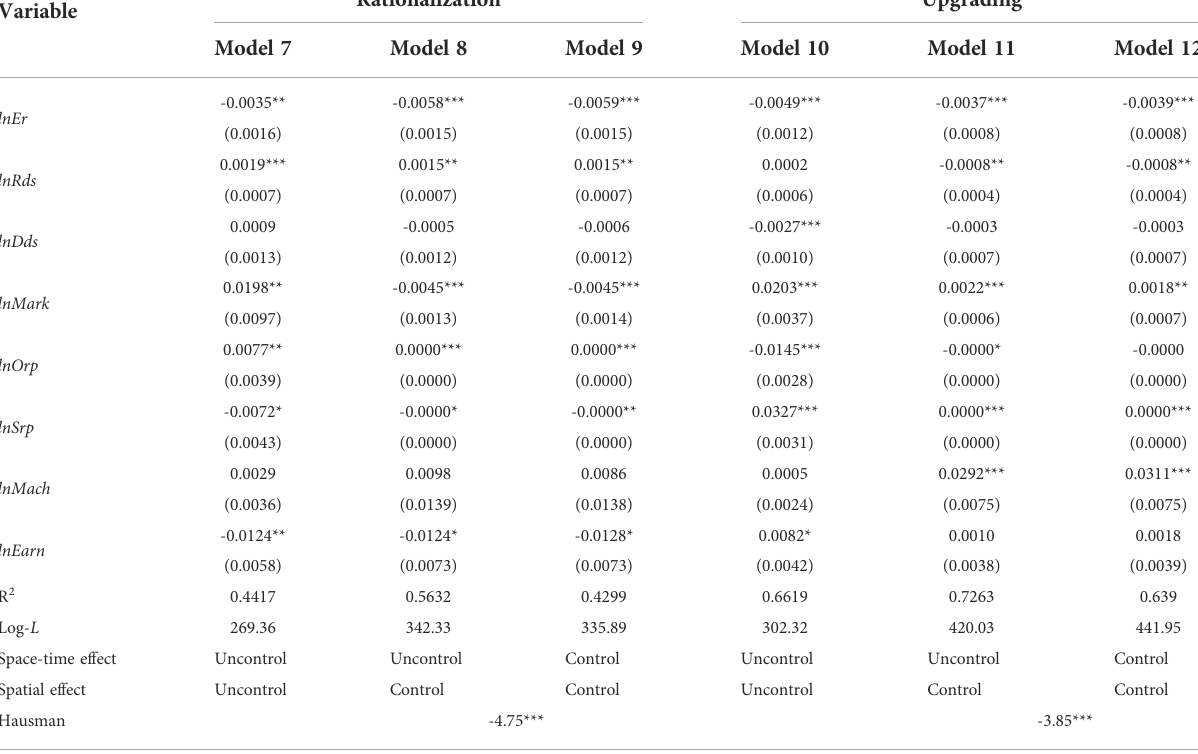
TABLE 7 Robustness test